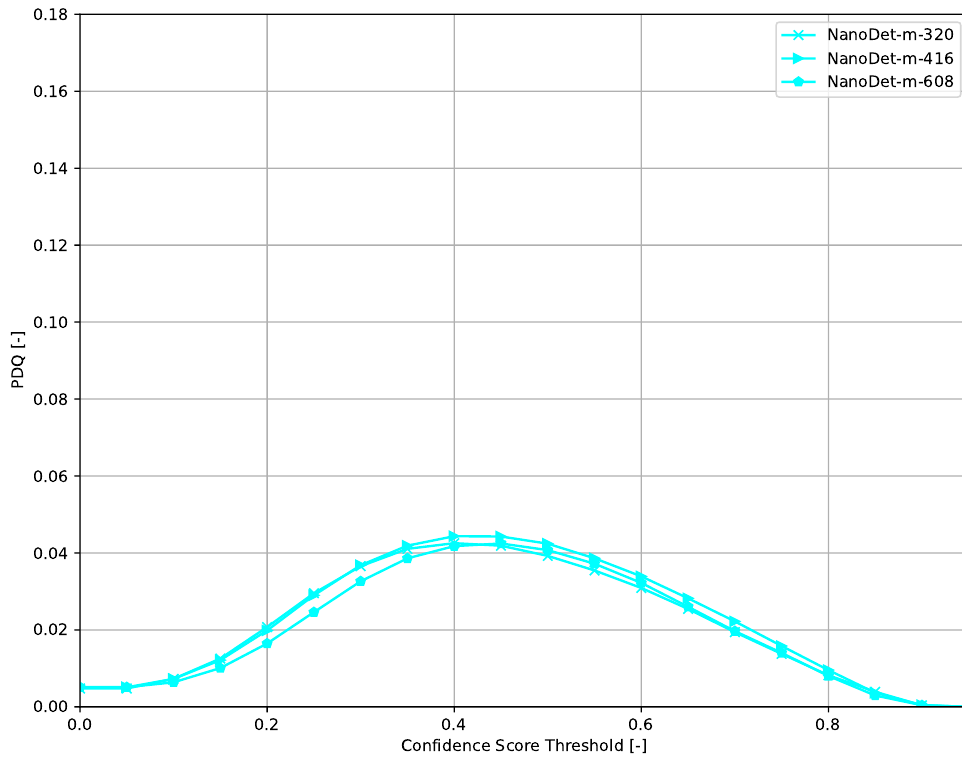
Figure 10. PDQ results of NanoDet on the COCO dataset.